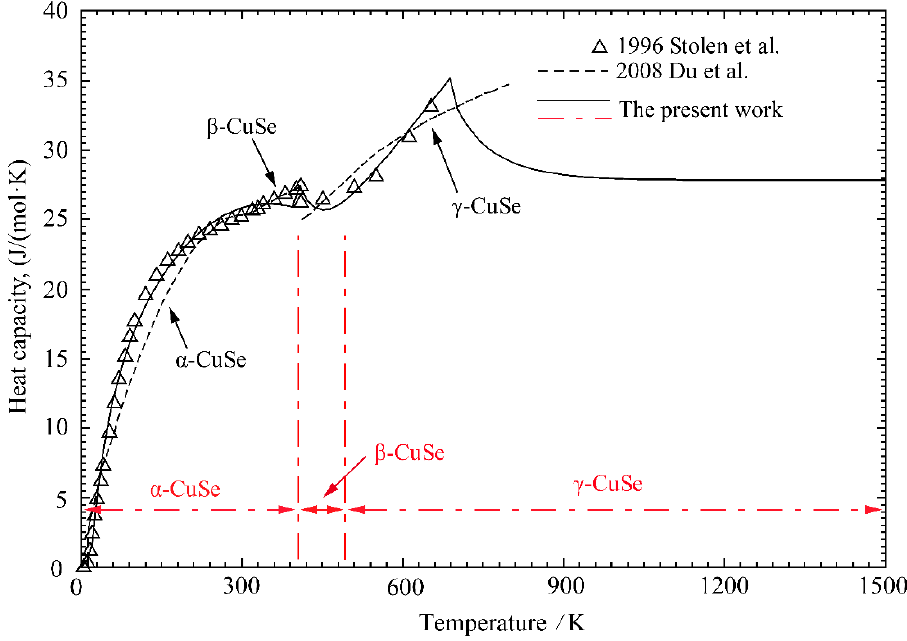
Figure 13. The calculated heat capacities of CuSe in the Cu-Se system compared with the experimental data from ref. [96] and previously optimized results by Du et al. [100].